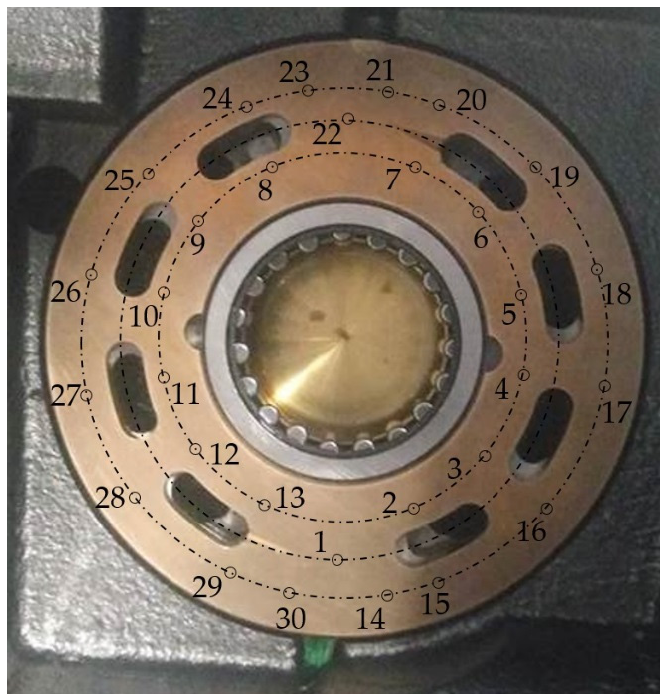
Figure 8. Position of the thermocouples in the valve plate.